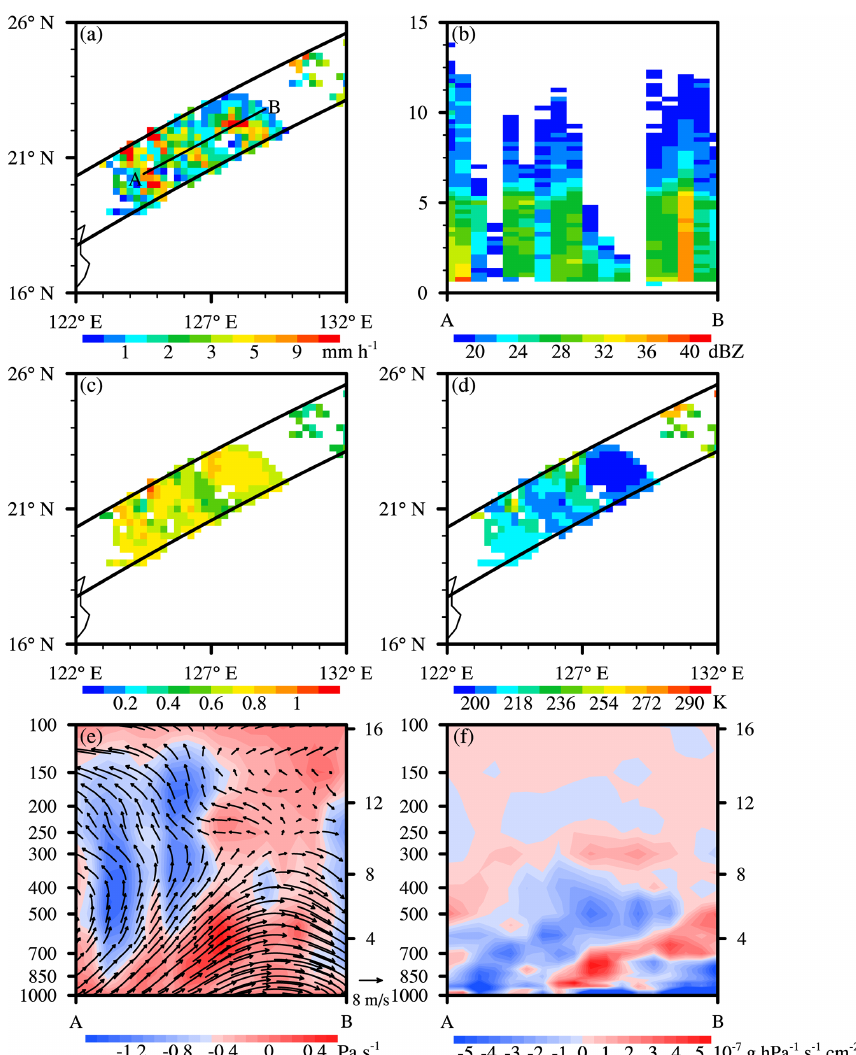
Figure 6. Case study of Typhoon Rananim precipitation on 10 August 2004 (orbit number 38395). (a) The near-surface rain rate, (b) vertical cross sections of the precipitation reflectivity factor, (c) RF1, (d) TB 10 . 8 , vertical cross sections of (e) the wind vectors and vertical velocity and (f) the divergence of water vapor flux along line A–B in panel (a)